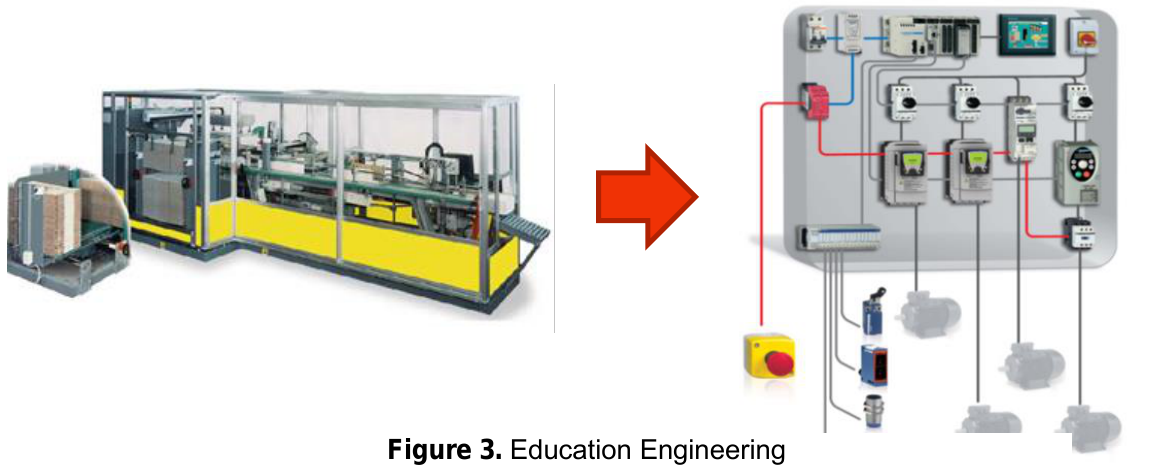
Figure 3. Education